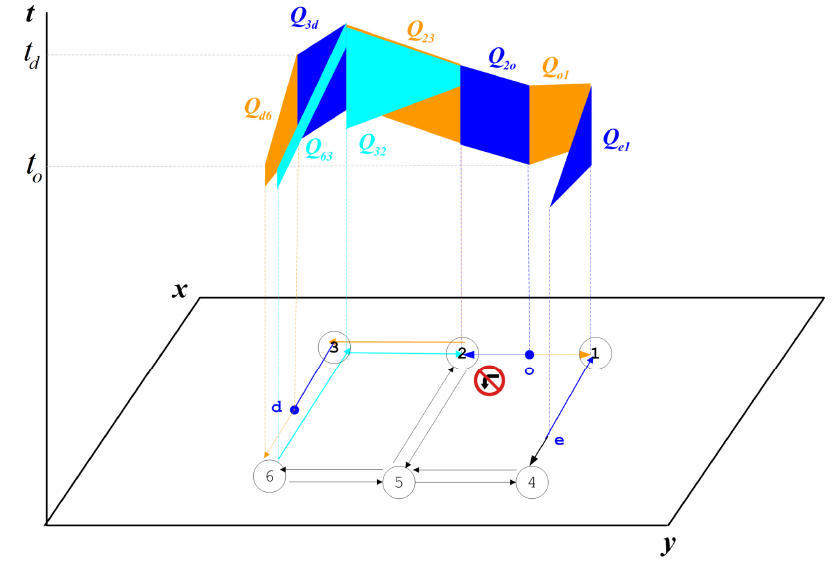
Figure 3. An illustrative network-time prism.